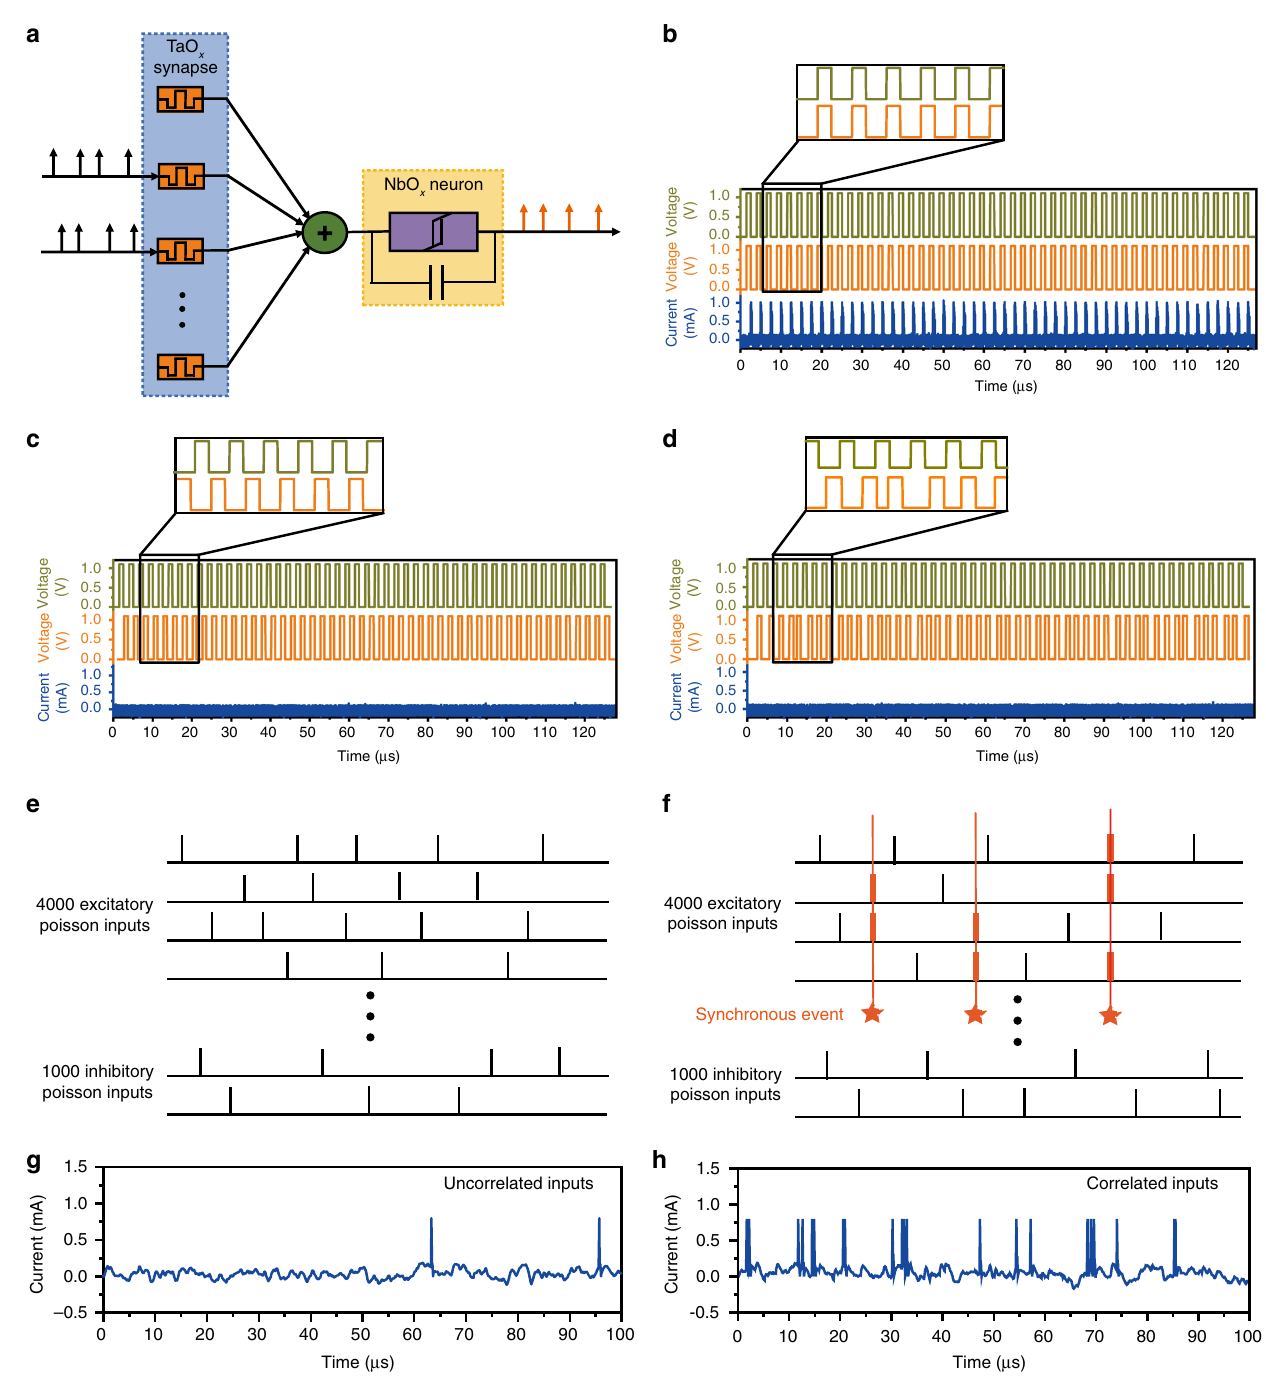
Fig. 7 Coincidence detection based on spatiotemporal dynamics. a Schematic diagram of coincidence detection in the fully memristive neural network. b The neuronal response by two synchronous input pulse trains (1.1 V in amplitude, 1 μ s in width, 1.5 μ s in interval, for 50 cycles) applied on S 1 and S 2 . c The neuronal response by two asynchronous input pulse trains (1.1 V in amplitude, 1 μ s in width, 1.5 μ s in interval, for 50 cycles) applied on S 1 and S 2 , where S 2 is behind S 1 by 1.2 μ s. d The neuronal response by two asynchronous input pulse trains (1.1 V in amplitude, 1 μ s in width, for 50 cycles) applied on S 1 and S 2 , where S 1 has and interval of 1.5 μ s and S 2 is random relative to S 2 in timing. e Input pulse trains of the neuron from independent 4000 excitatory and 1000 inhibitory random spike trains following Poisson statistics. f Introduction of synchronous events following Poisson statistics into the excitatory inputs, where the input rates are unchanged and the proportion of synchronous events is 0.3%. g Simulated neuronal response as a result of the inputs shown in e , where the arti fi cial neuron only fi res 2 spikes. h Simulated neuronal response as a result of the inputs shown in f , where the arti fi cial neuron fi res 21